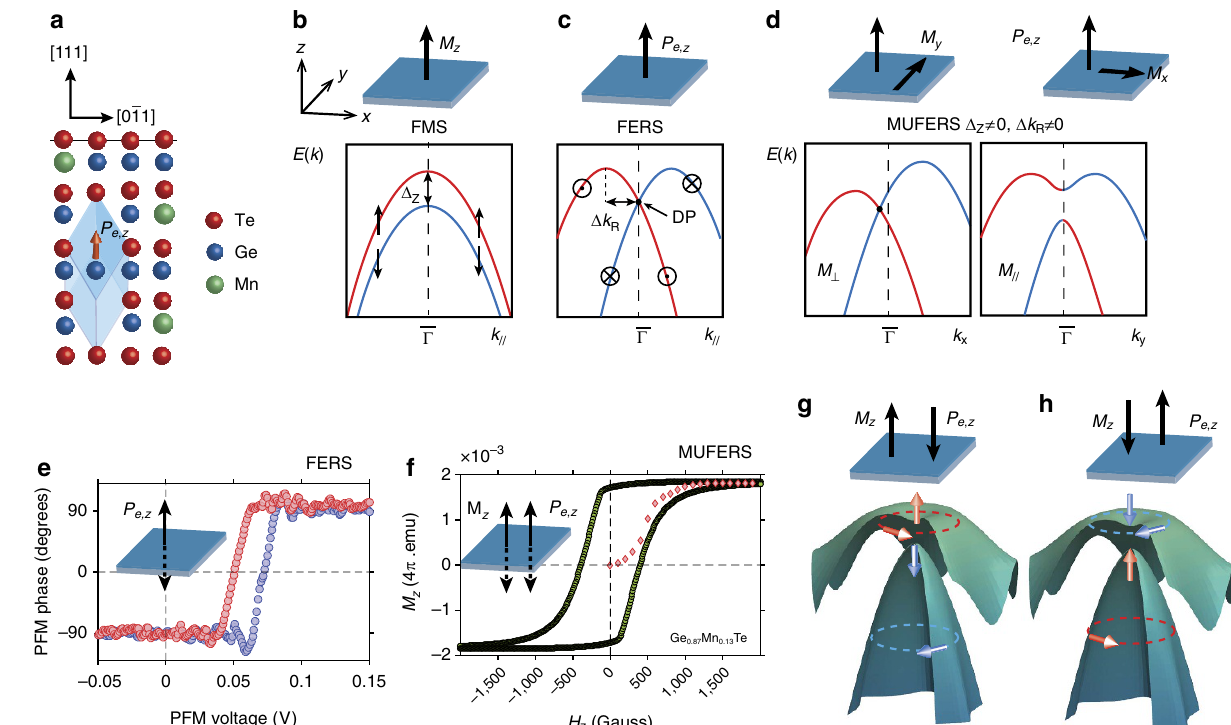
Figure 1 | Basic properties. ( a ) Sketch of multiferroic Ge 1 (cid:2) x Mn x Te with FE displacement of Ge(Mn)-atoms inside the rhombohedrally distorted unit cell along [111] as indicated by the orange arrow. ( b ) Schematic Rashba-gas band maps of a ferromagnetic semiconductor (FMS) compared with a ferromagnetic Rashba semiconductor (FERS) ( c ) and a multiferroic Rashba semiconductor (MUFERS) in d , with their dependence on the orientations of the FM ( M ) and FE ( P e ) order (see text). ( e ) Typical out-of-plane FE phase hysteresis measured by piezo-force-microscopy for FE GeTe and preserved in Ge 1 (cid:2) x Mn x Te (ref. 8). ( f ) Out-of-plane FM hysteresis curve of multiferroic Ge 0.87 Mn 0.13 Te measured by SQUID. ( g , h ) Band plots of the two upper occupied RZ-split valence bands as a function of k -vectors around Z-point of Ge 1 (cid:2) x Mn x Te and corresponding spin-texture switching upon colinear reversal of M z and P z